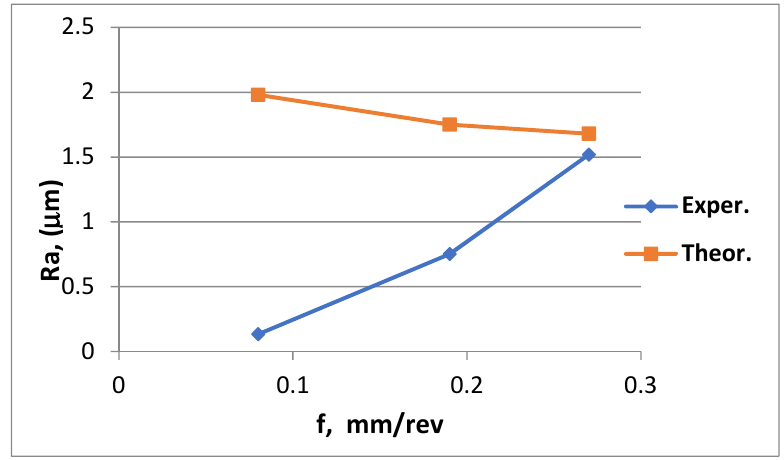
Figure 15. Comparison of experimental and theoretical values for the surface roughness Ra parameter.